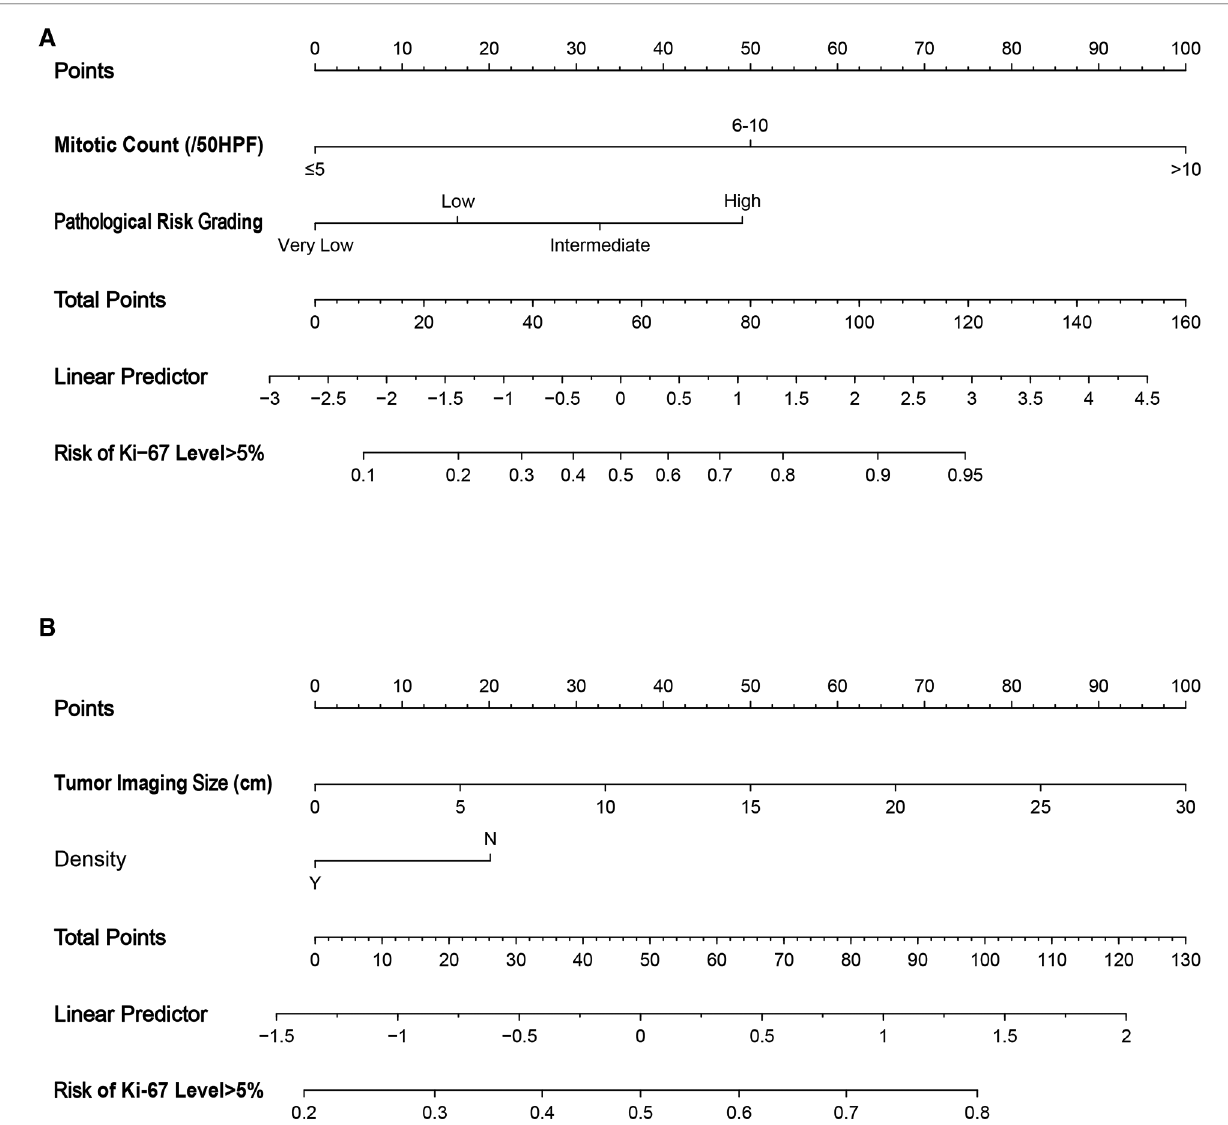
FIGURE 2 Nomograms to evaluate the risk of Ki-67 level >5% in GIST patients. Method of use: fi nd the position of each variable on the corresponding axis, draw a line to the points axis for the number of points, add the points from all of the variables, and draw a line from the total points axis to determine the risk of Ki-67 level >5% at the lower line of the nomogram. ( A ) Pathological features; ( B ) CT signs. HPF, high power fi